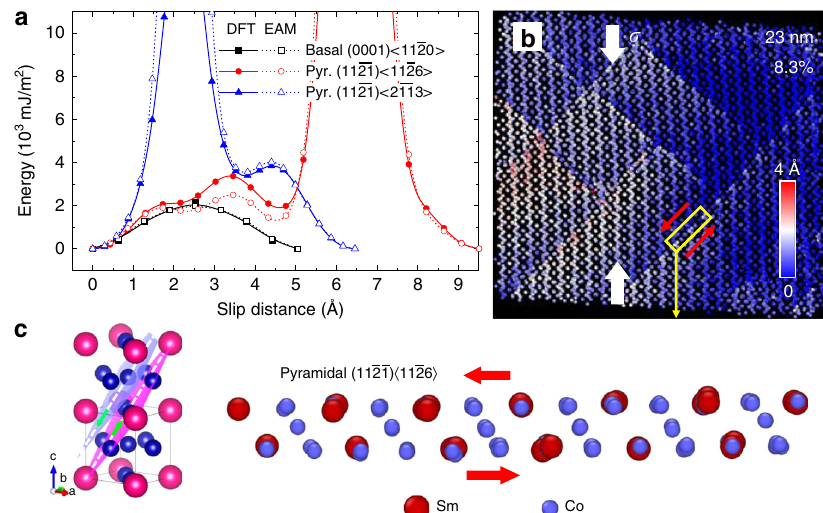
Fig. 2 Incomplete dislocation slip in SmCo 5 . a Potential energy surfaces (PESs) of basal and pyramidal slips calculated by using DFT and EAM potential. (cid:1) (cid:3) (cid:4) (cid:5)(cid:6) (cid:7) 11 (cid:1) 26 in a grain of the sample with a grain diameter of 23 nm under compressive strain of 8.3%. Atoms are colored by their b Pyramidal 2 c + a slip 11 (cid:1) 2 (cid:1) 1 displacements using the unstrained structure as the reference. White arrows represent external stress and red arrows show the direction of the resolved shear stress. c Atomic-level view of the pyramidal 2 c + a